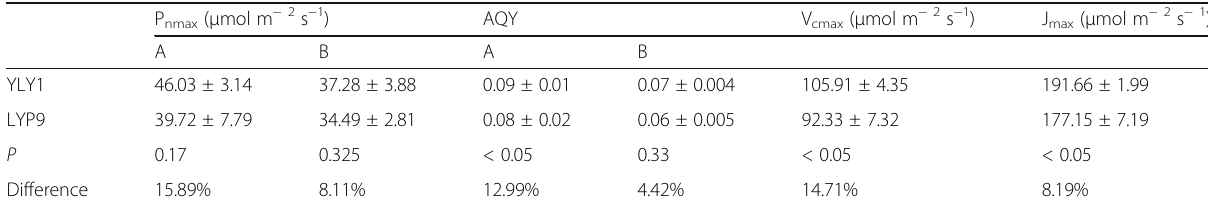
Table 4 Parameters derived from the light response curves of CO 2 fixation, the maximal Pn at light saturation point (Pnmax), apparent quantum yield (AQY) and dark respiration rate (Rd). The ambient CO 2 concentration during measurements was 380 – 400 ppm in EMS (Early milk stage) (A) and 385 ppm in LMS (late milk stage) (B). Maximum rates of carboxylation at both CO 2 and RuBP saturation (Vcmax) and maximum rate of electron transport (Jmax) derived from the CO 2 response curves of photosynthetic CO 2 uptake rate measured in 2013. n = 3